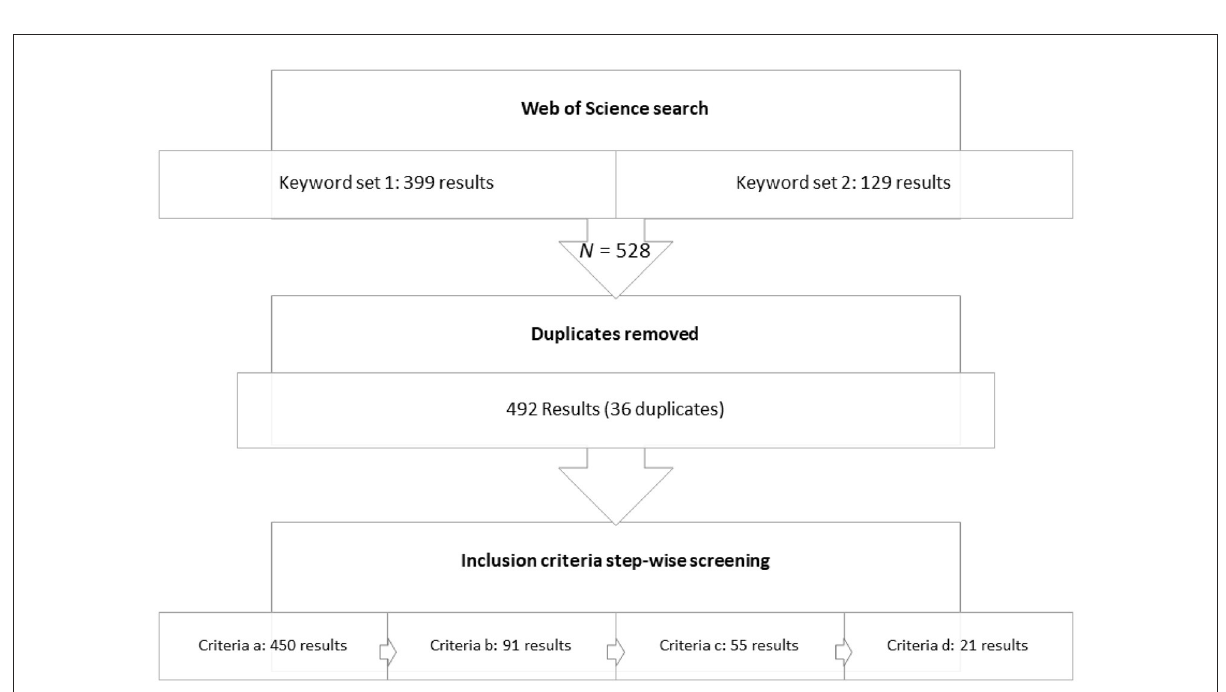
FIGURE1 Flow chart of literature screening process (results shown from the main search).